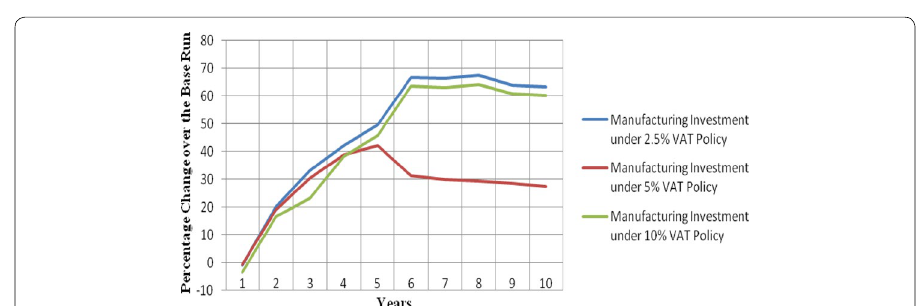
Fig. 24 Changes in manufacturing investment under varying VAT rates